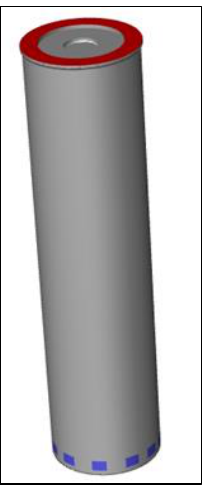
Figure 3. Prilling tower model diagram.